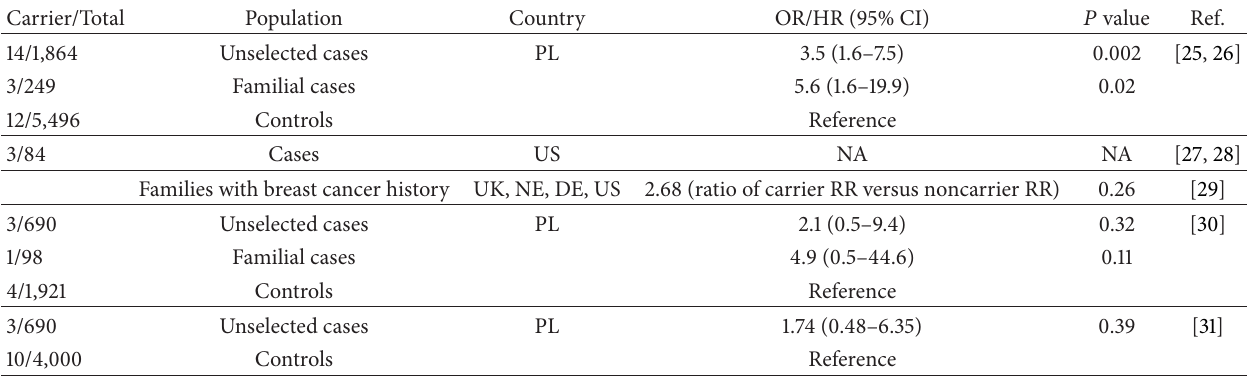
Table 2: Characteristics and results of 7 excluded prostate cancer